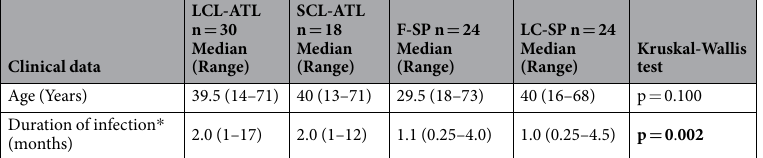
Table 1. Distribution of age and duration of infection in American tegumentary leishmaniasis and sporotrichosis patients. LCL-ATL: localized cutaneous leishmaniasis; SCL-ATL: sporotrichoid cutaneous leishmaniasis; F-SP: fixed sporotrichosis; LC-SP: Lymphocutaneous sporotrichosis. * Elapsed Time between the beginning of the cutaneous lesions and the diagnostic procedures in INI-FIOCRUZ. Bonferroni post hoc